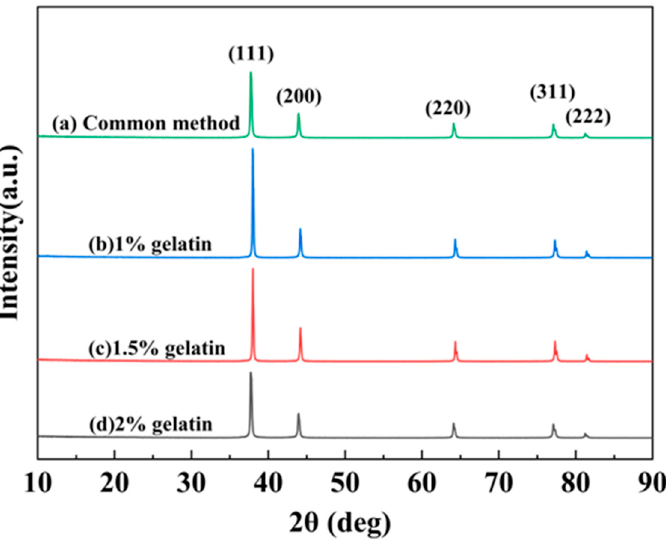
Figure 3. XRD patterns of silver powders were obtained using different preparation methods. (a) Conventional method; (b) microinjection method by adding 1% gelatin; (c) microinjection method by adding 1.5% gelatin; and (d) microinjection method by adding 2% gelatin. As seen in Figure 3, the spectral lines have characteristic peaks at 38.1°, 44.23°, 64.37°, 77.36°, and 81.46°, which correspond to the (111), (200), (220), (311), and (222) crystal planes of cubic crystalline silver, respectively. Furthermore, these spectral lines are con- sistent with the monolithic silver standard pattern (JCPDS 04-0783). There were no other